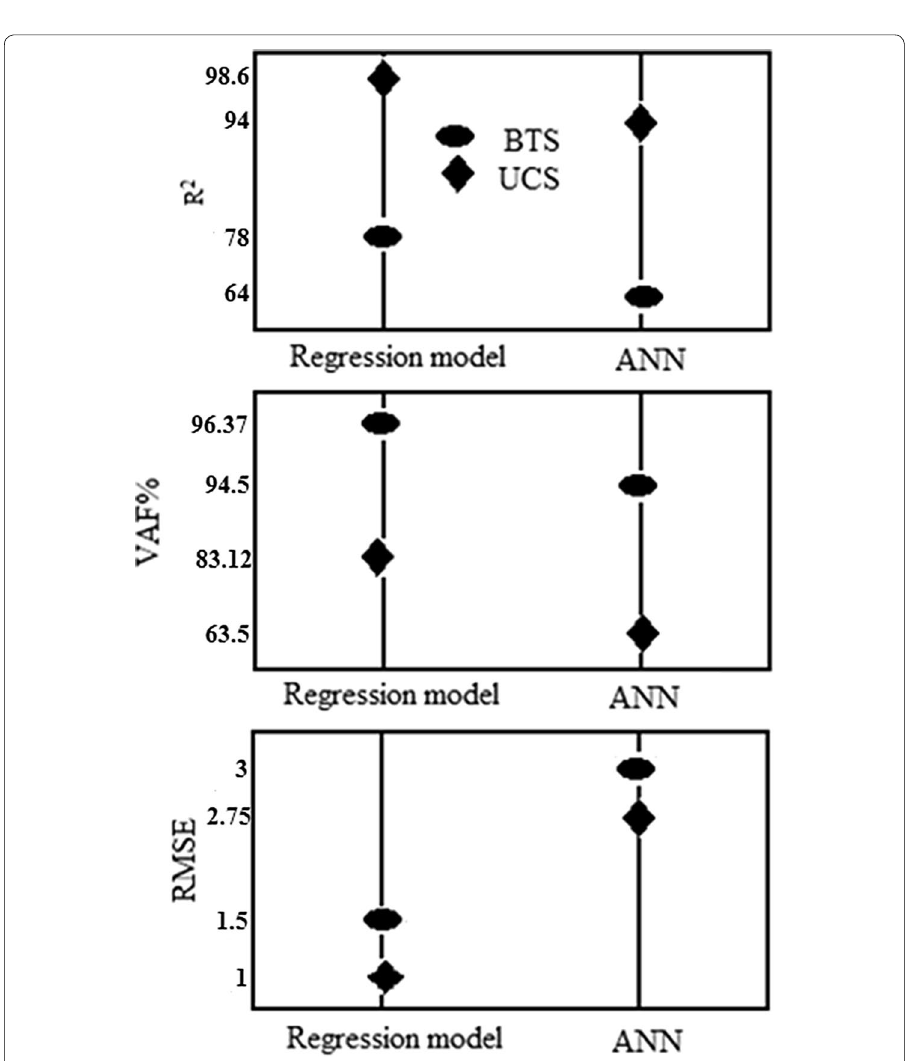
Fig. 7 Comparison of the values of RMSE, VAF, R 2 for Regression model, ANN